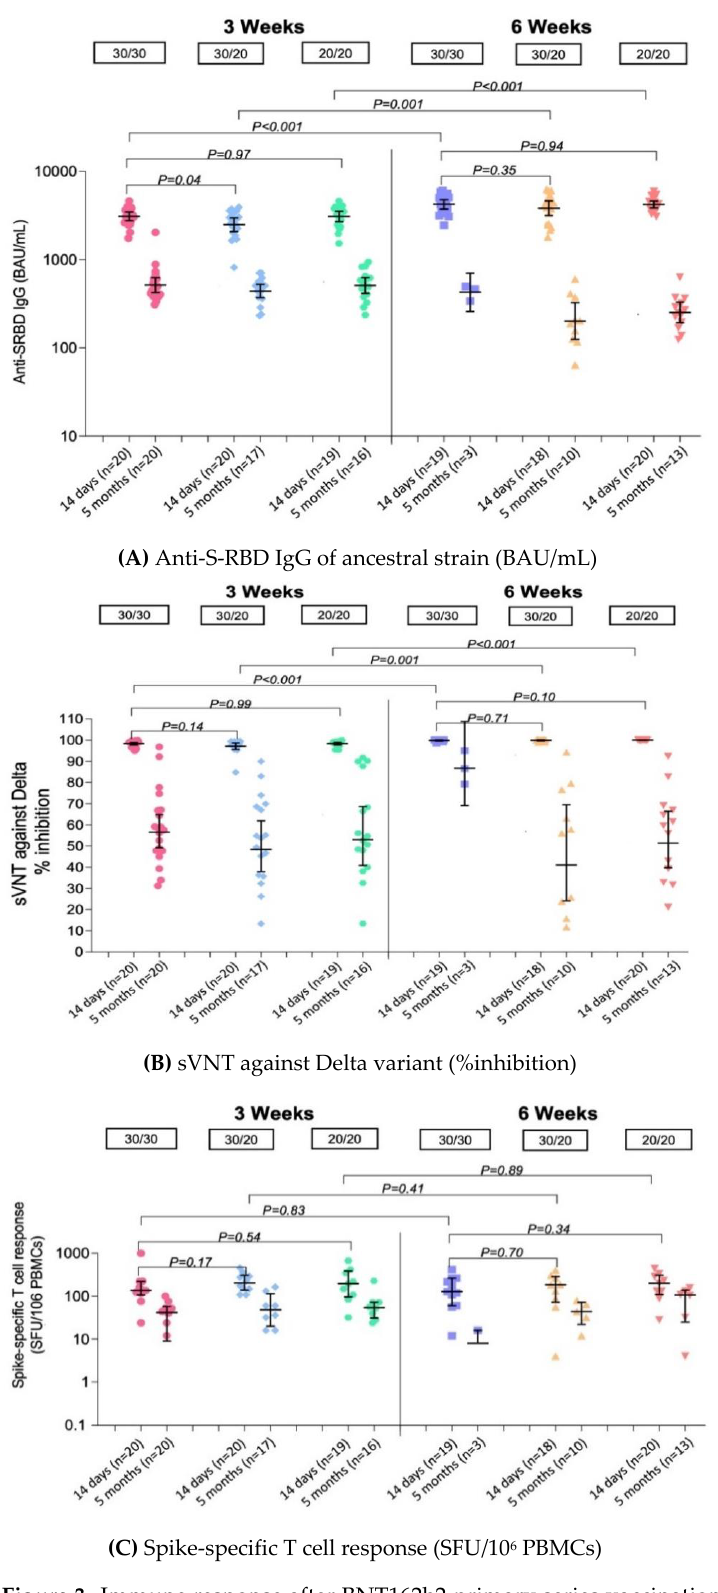
Figure 3. Immune response after BNT162b2 primary series vaccination in healthy adolescents by vaccination groups: ( A ) Anti-S-RBD IgG of ancestral strain (BAU/mL) ( B ) sVNT against Delta variant (%inhibition) ( C ) Spike-specific T cell response (SFU/10 6 PBMCs) Anti-S-RBD IgG: anti spike protein receptor-binding-domain IgG; sVNT: surrogate virus neutralization test; SFU: Spot forming unit; PBMC: Peripheral blood mononuclear cell.